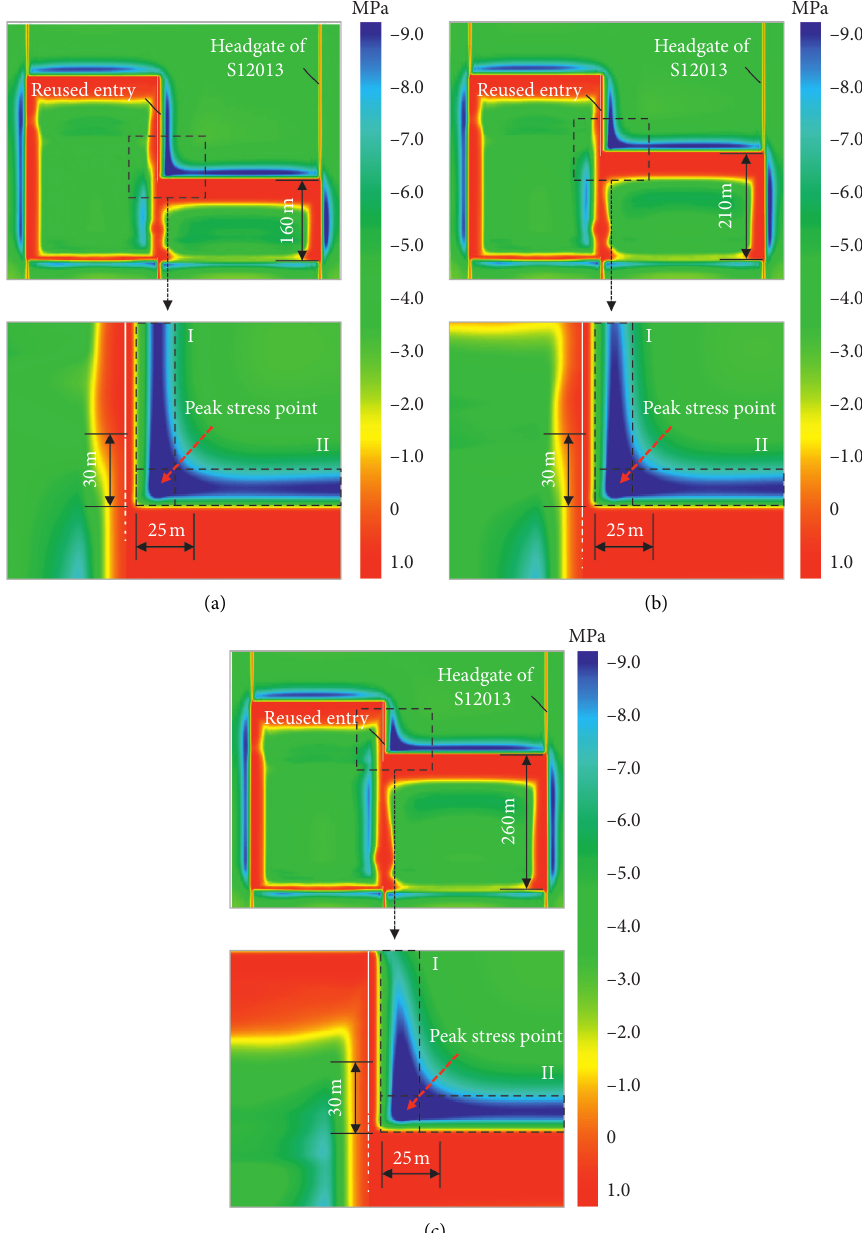
Figure 6: Stress field distribution in the S12013 working face with advance distance (a) 160m, (b) 210m, and (c) 260